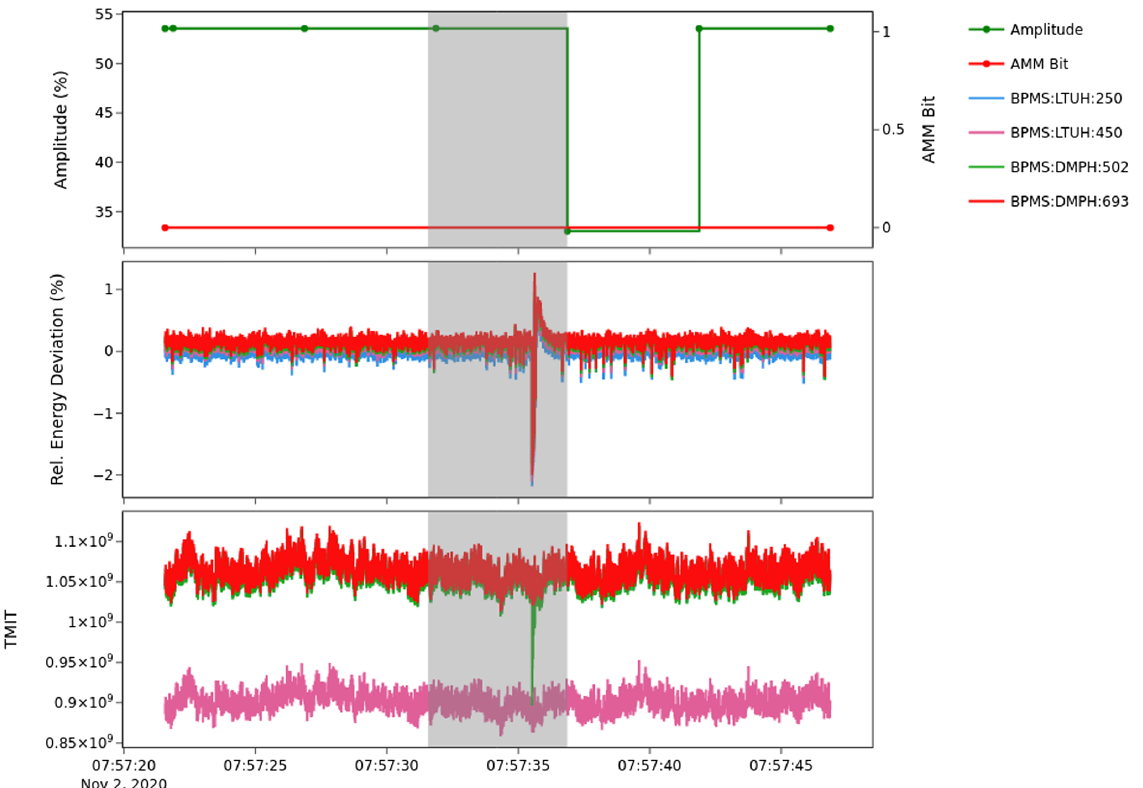
FIG. 5. Example of a sustained anomaly at KLYS:LI28:11. The top plot shows the klystron diagnostic data (both the AMM status bit and the AMPL signal). The middle plot shows the relative energy deviation (calculated from the beam position in the dispersive plane), with a brief but large deviation followed by a recovery period. The bottom plot shows the TMIT readings (which is the approximate number of electrons, subject to some calibration). The gray region defines the implied anomaly window, due to the delayed reporting of the klystron health information. Note this anomaly is missed by AMM.